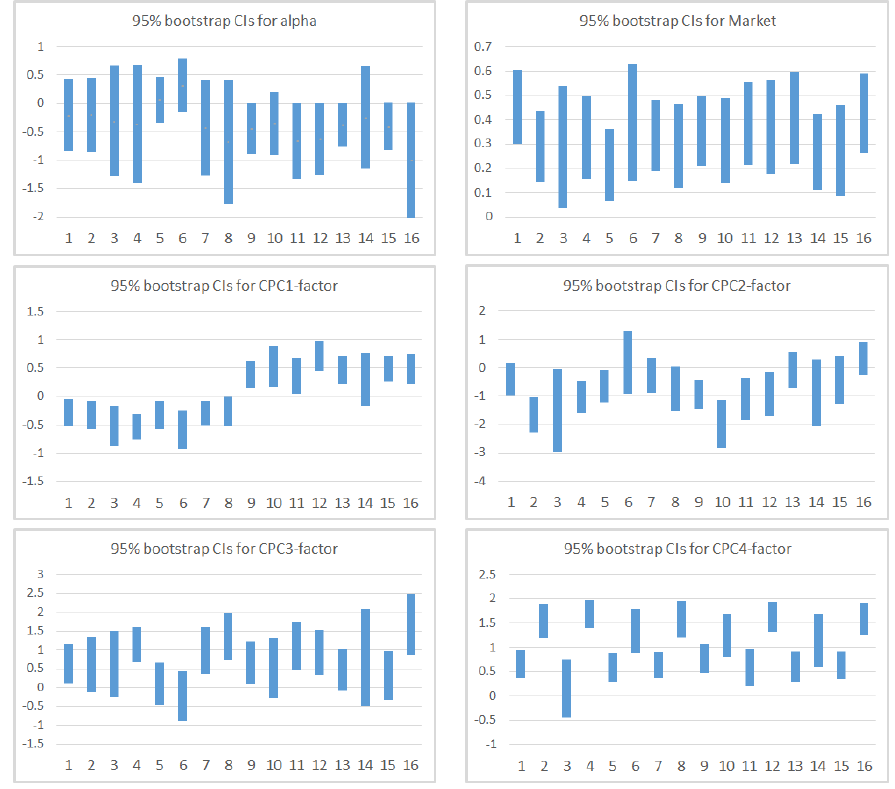
Figure 6. Graphical comparison of 95% Bootstrap CIs for Model